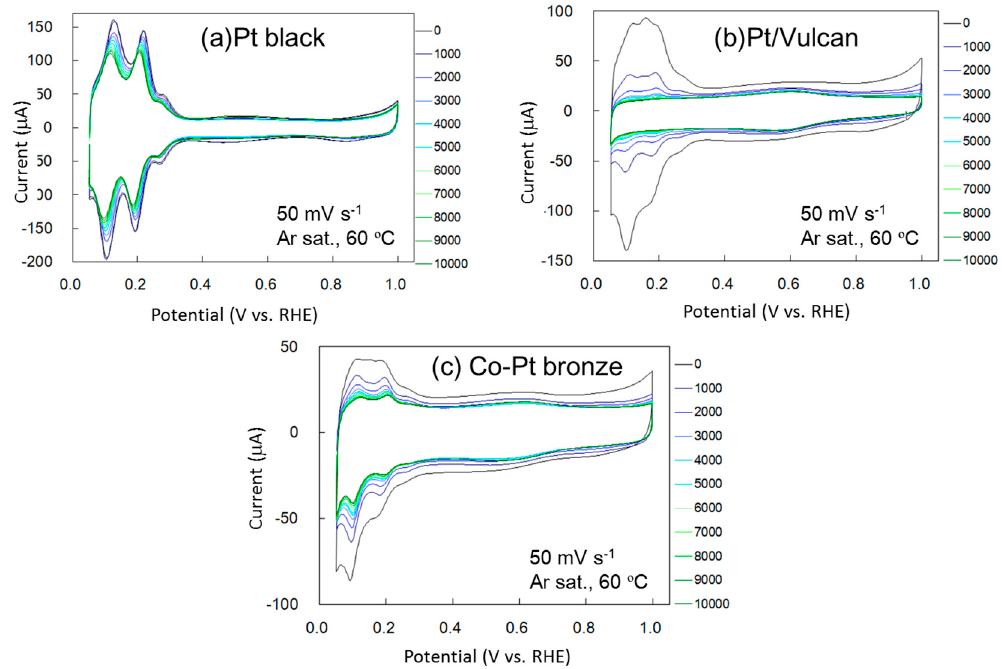
Figure 13. Cyclic voltammograms during the accelerated durability test after 0 to 10,000 cycles. ( a ) Pt black; ( b ) Pt/Vulcan and ( c ) Co-Pt bronze.